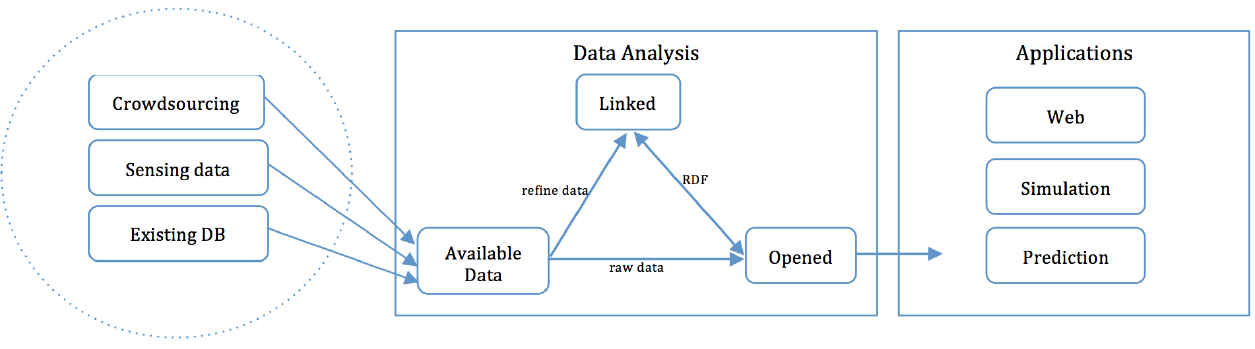
Figure 4. Model for Environmental services with